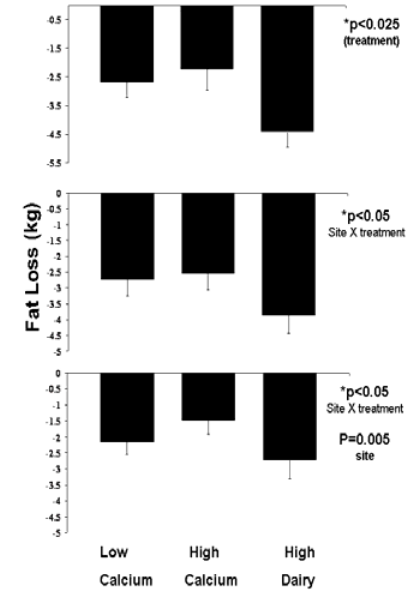
Figure 1. Effects of dietary treatments on fat loss. Top panel: Adherent subjects. Middle panel: All subjects completing the study. Bottom panel: Intent-to-treat analysis. All data are presented as mean ± standard error.